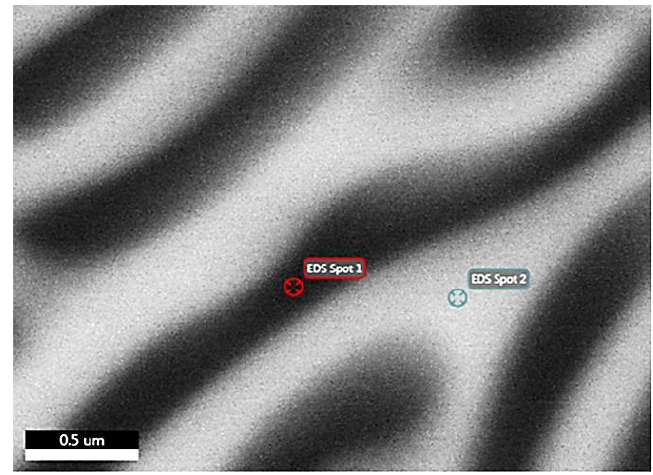
Figure 7. FESEM backscatter electron microstructure of sample 1M in the stripe area. Table 7. Elemental composition of the manufactured alloy in eutectic region of sample 1M obtained by EDS.